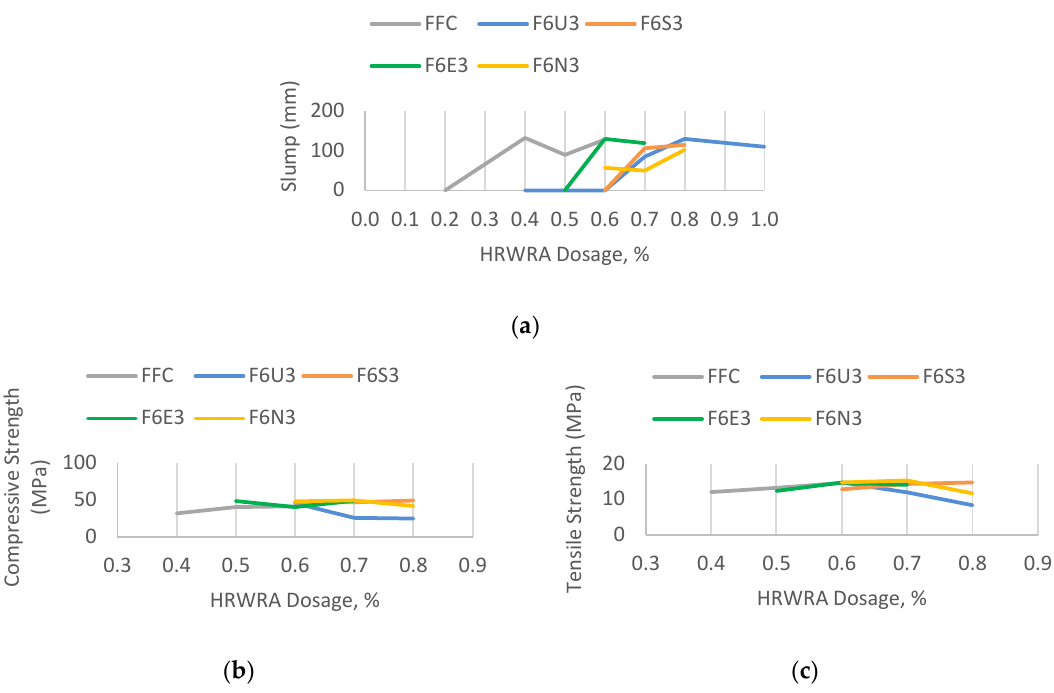
Figure 4. The ( a ) slump comparison and the ( b ) compressive and ( c ) tensile strength at 28-days.